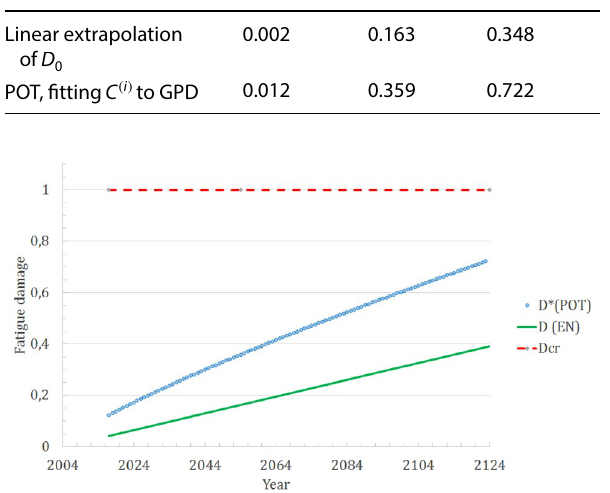
Table 2 Fatigue damage obtained with linear extrapolation of D 0 and POT Method